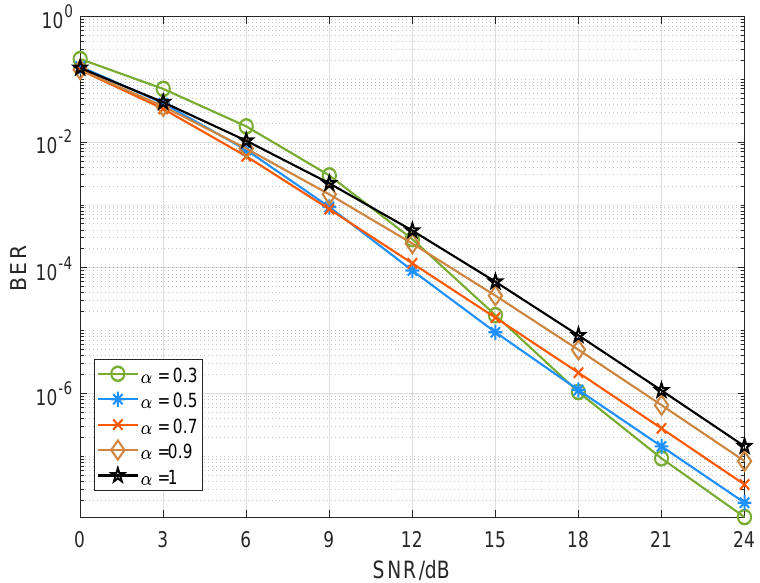
Figure 3. BER performance of the binary phase shift keying-modulated STBC-VBLAST-TPA system of α = 0.3,0.5,0.7,0.9,1 having M = 3 and N = 3.